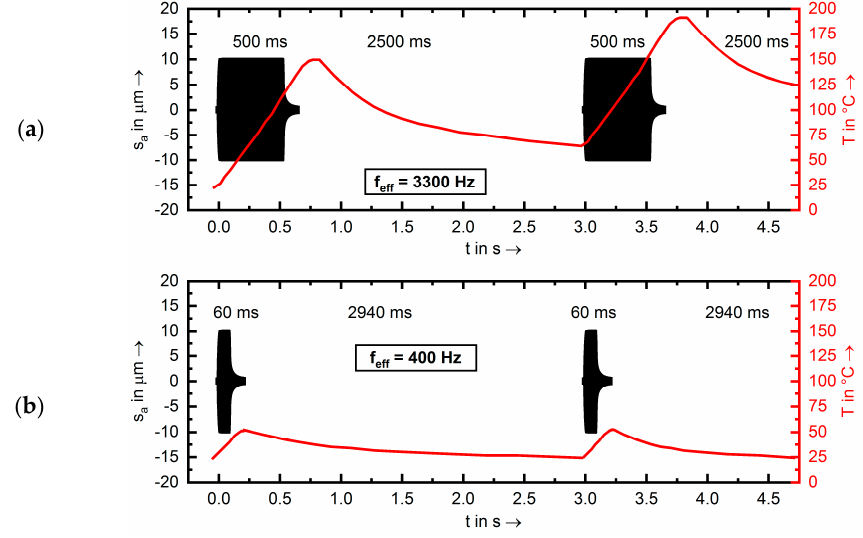
Figure 5. Development of the specimen’s temperature using a pulse/pause ratio of ( a ) 0.5 s/2.5 s and ( b ) 0.06 s/2.94 s for AISI 347 batch